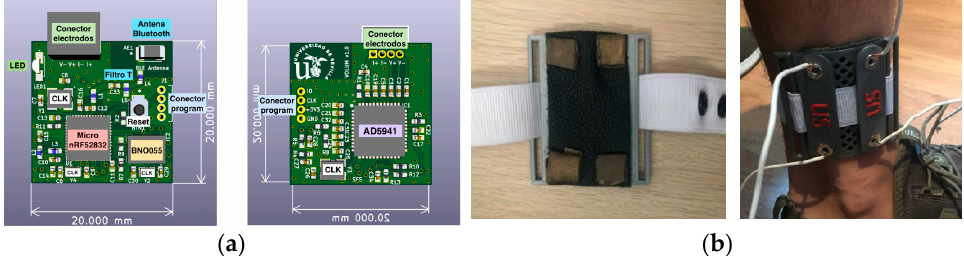
Figure 1. General overview VOLUM system: ( a ) Proposed circuits. ( b ) Ankle support with elec- trodes.